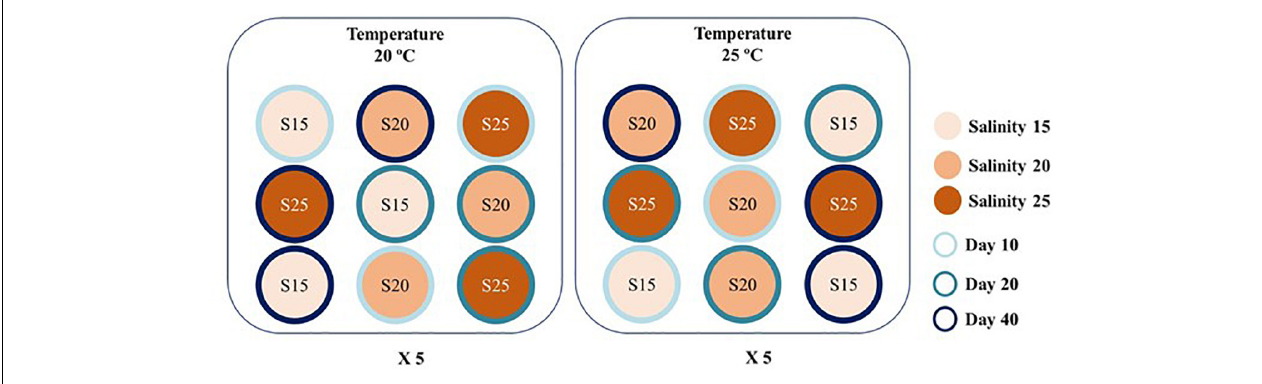
FIGURE 1 | Schematic representation of one of the five replicate water baths used to control temperatures (20 and 25 ◦ C) housing randomly distributed glass flasks stocked with 10 Hediste diversicolor at different salinities (S—15, 20, and 25) to evaluate the evolution of their fatty acid profiles after being fed a commercial aquafeed during 10, 20, and 40 days (D10, D20, and